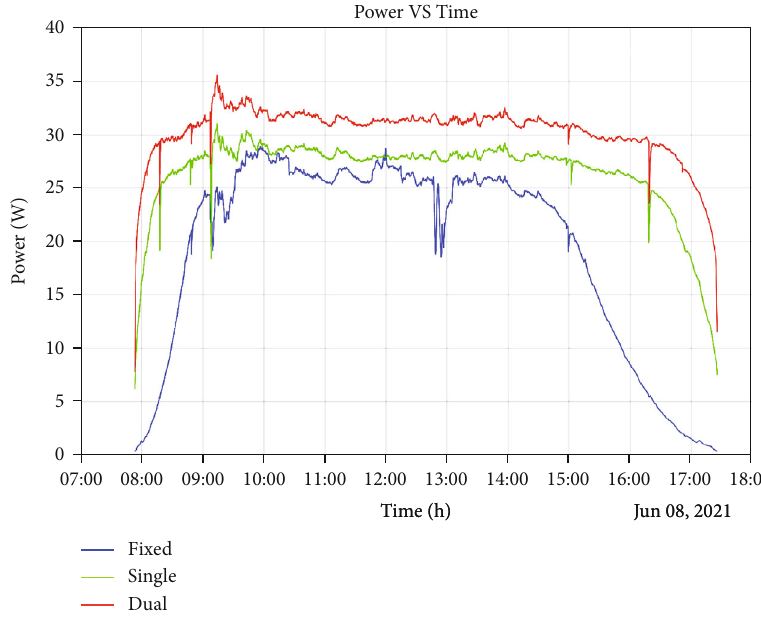
Figure 8: FTPV, SAST, and DAST power generation.